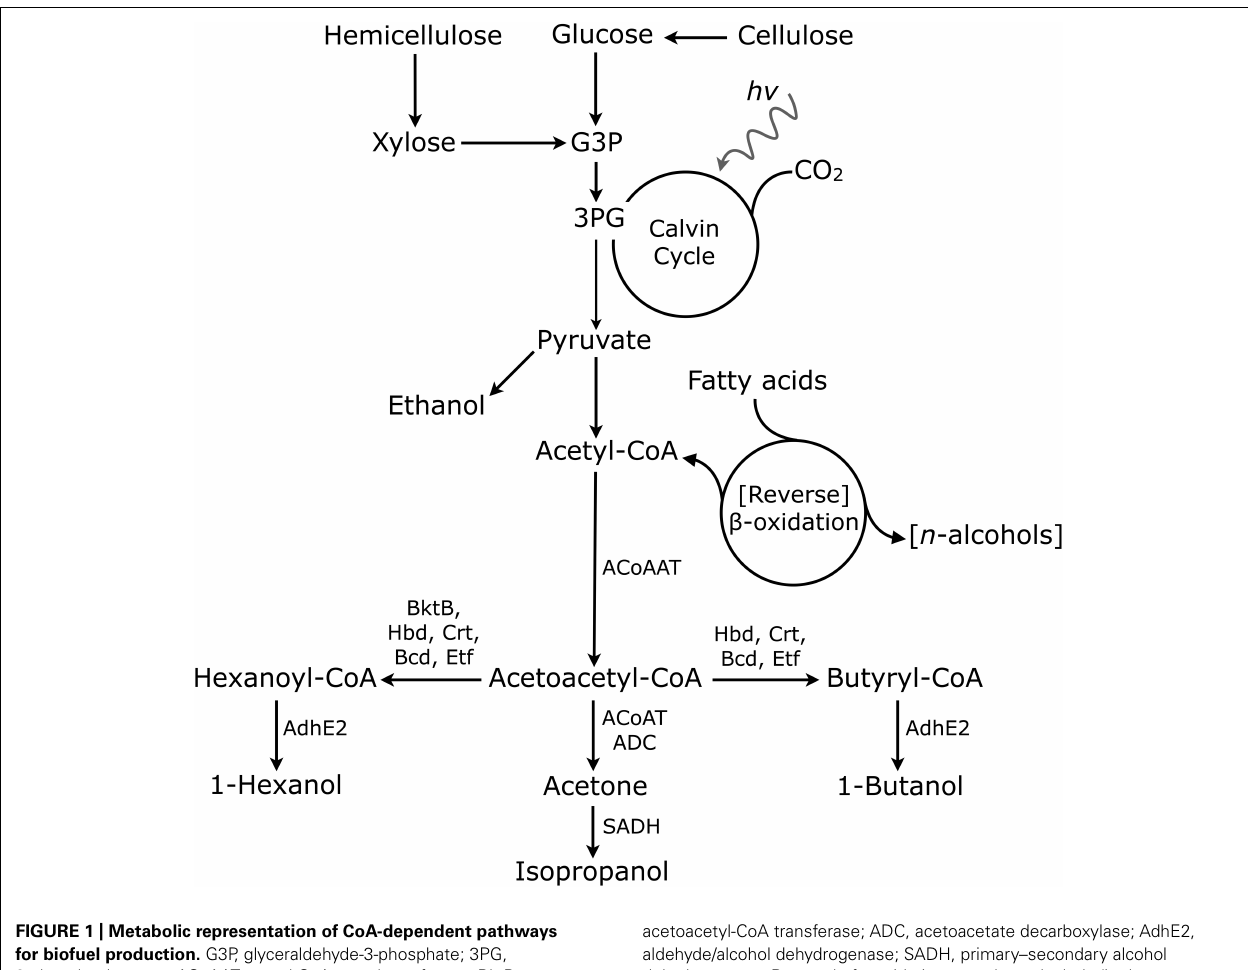
FIGURE 1 | Metabolic representation of CoA-dependent pathways for biofuel production. G3P, glyceraldehyde-3-phosphate; 3PG, 3-phosphoglycerate; ACoAAT, acetyl-CoA acetyltransferase; BktB, 2-ketothiolase; Hbd, 3-hydroxybutyryl-CoA; Crt, crotonase; Bcd, butyryl-CoA dehydrogenase; Etf, electron transfer flavoprotein; ACoAT,